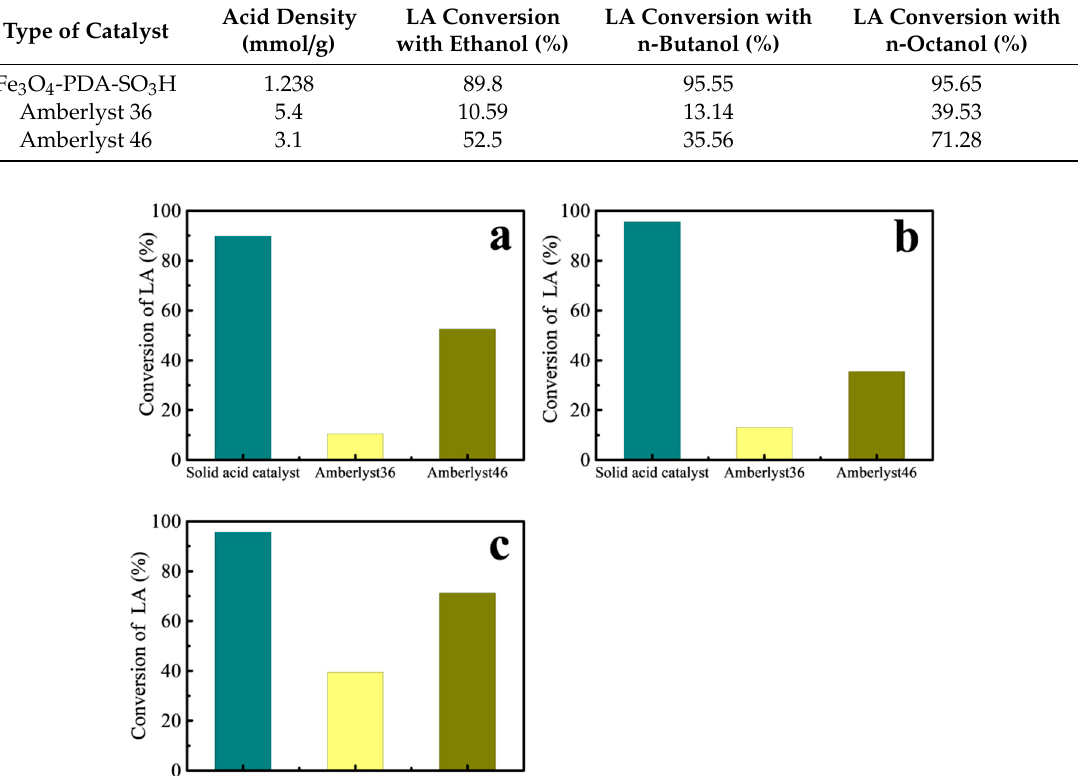
Figure 13. Different catalysts for the esterification of levulinic acid with ( a ) ethanol operated at reaction temperature: 90 °C, reaction time: 5 h, and catalyst mass: 0.116 g, ( b ) n-butanol operated at reaction temperature: 90 °C, reaction time: 5 h, and catalyst mass: 0.0266 g 0.0463 g, and ( c ) n-octanol operated at reaction temperature: 90 °C, reaction time: 5 h, and catalyst mass: 0.0463 g.